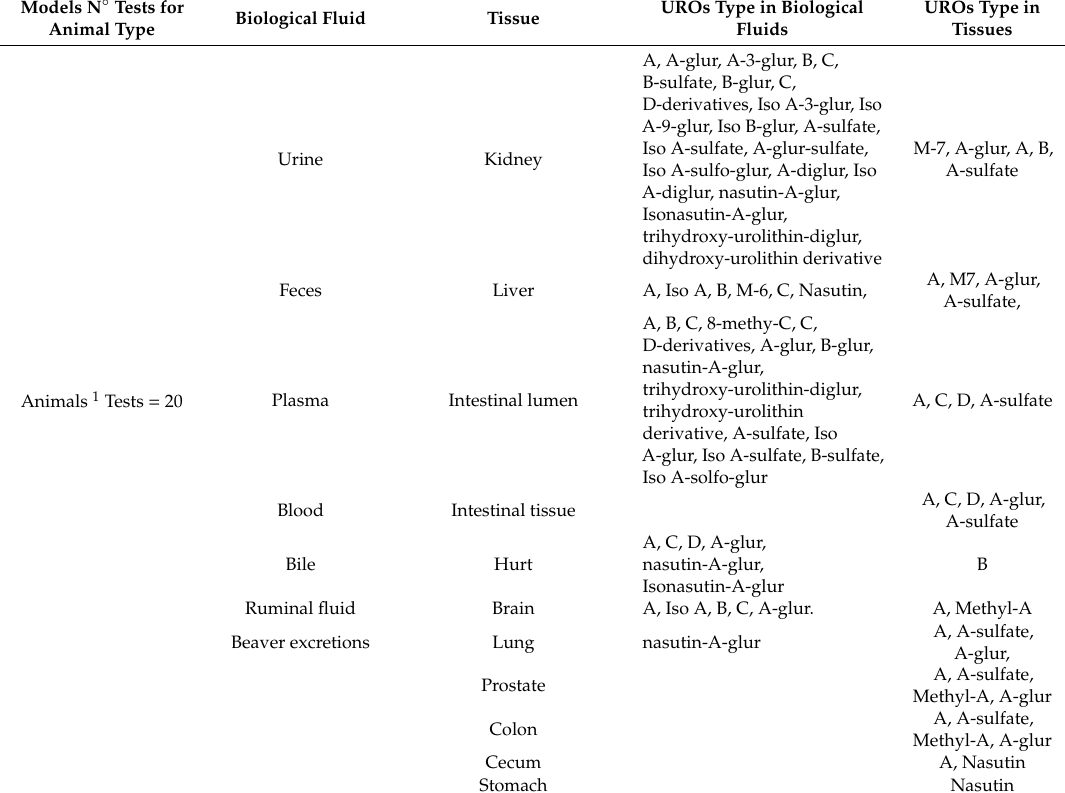
Table 12. Animal and human biological fluids and tissues where UROs and / or their conjugates and / or nusatins were detected in several experimental types and conditions and after intake of di ff erent ET-rich foods